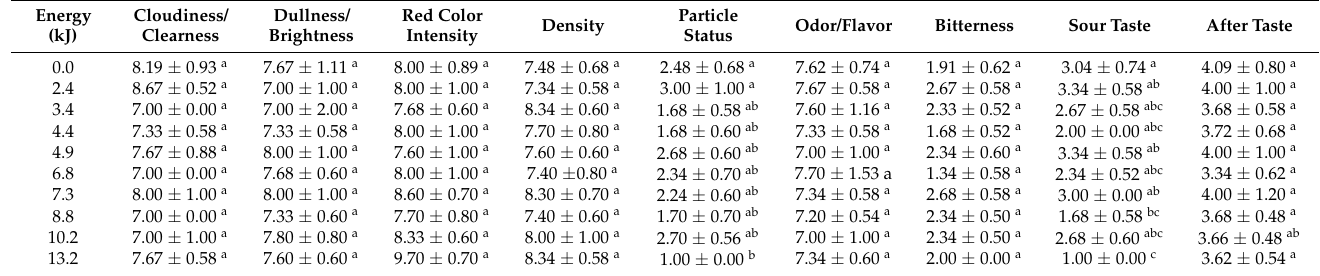
Table 4. Changes in the sensory properties of red wine samples treated by pulsed electric